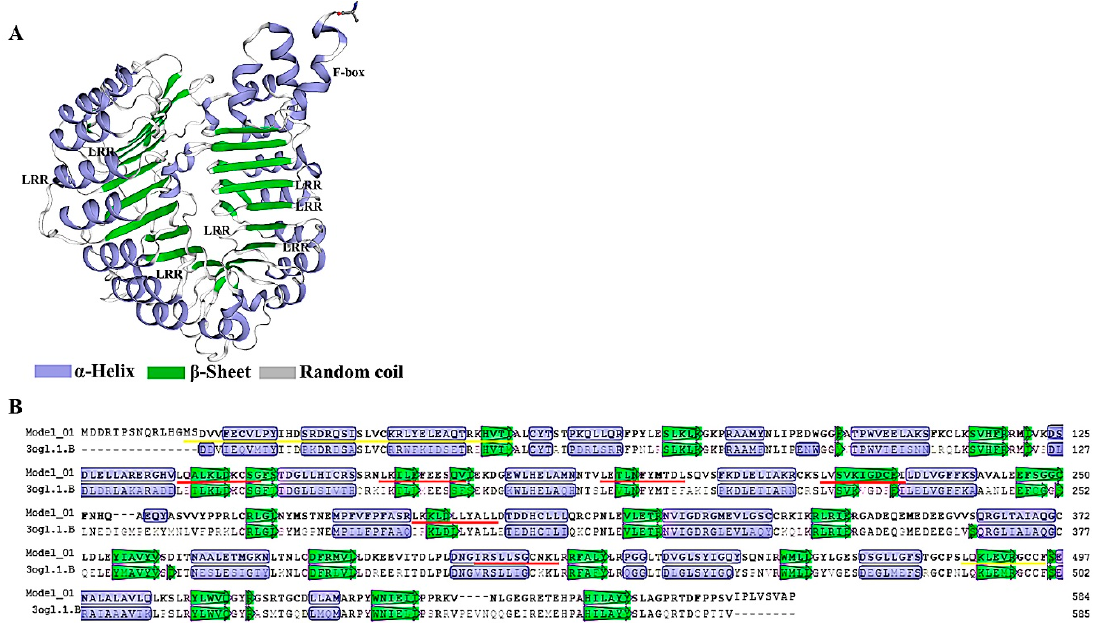
Figure 2. The predicted AaCOI1 3D mode ( A ) and the contribution of amino acid residues to the structure ( B ). The LRRs and F-box are indicated in the figure. The LRRs are marked by red lines, while the F-box is marked by a yellow line ( B ).